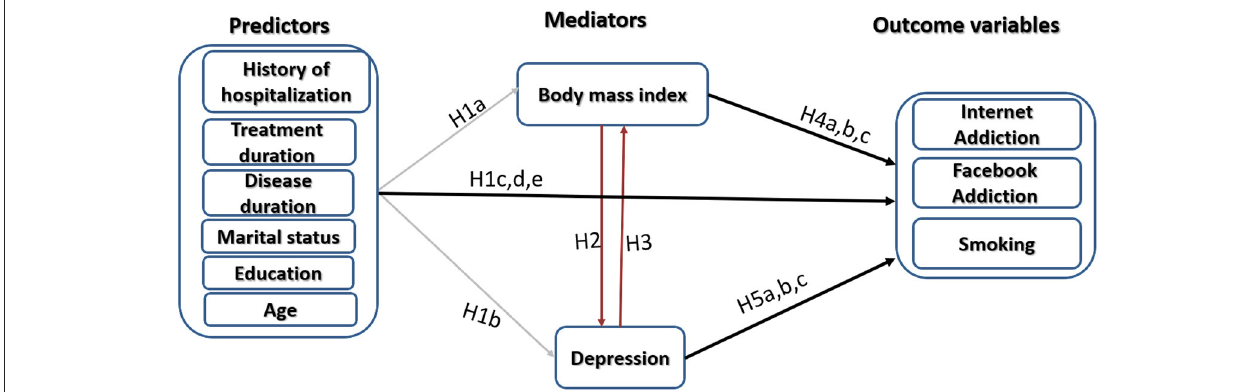
FIGURE 1 | Schematic illustration of the model used to test hypotheses of the present study. Hypothesis 1a (H1a): Sociodemographic and clinical characteristics contribute to altered body mass index in patients with EDs. Hypothesis 1b (H1b): Sociodemographic and clinical characteristics contribute to depression in